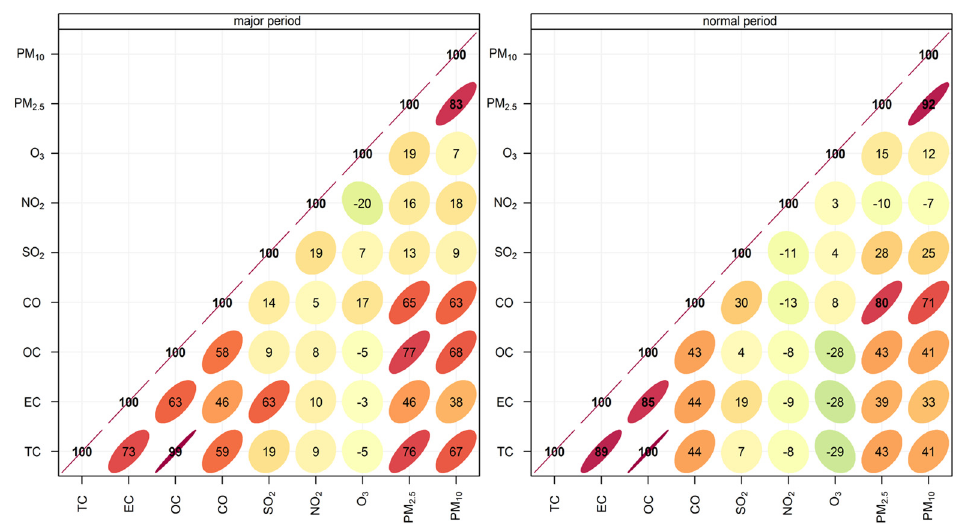
Figure 4. Correlation of atmospheric pollutants in different periods (i.e., major and normal periods) of the Spring Festival in Changchun in 2018. The correlation degree between pollutants is displayed synergistically by the shape (i.e., ellipses), colors, and numerical values.